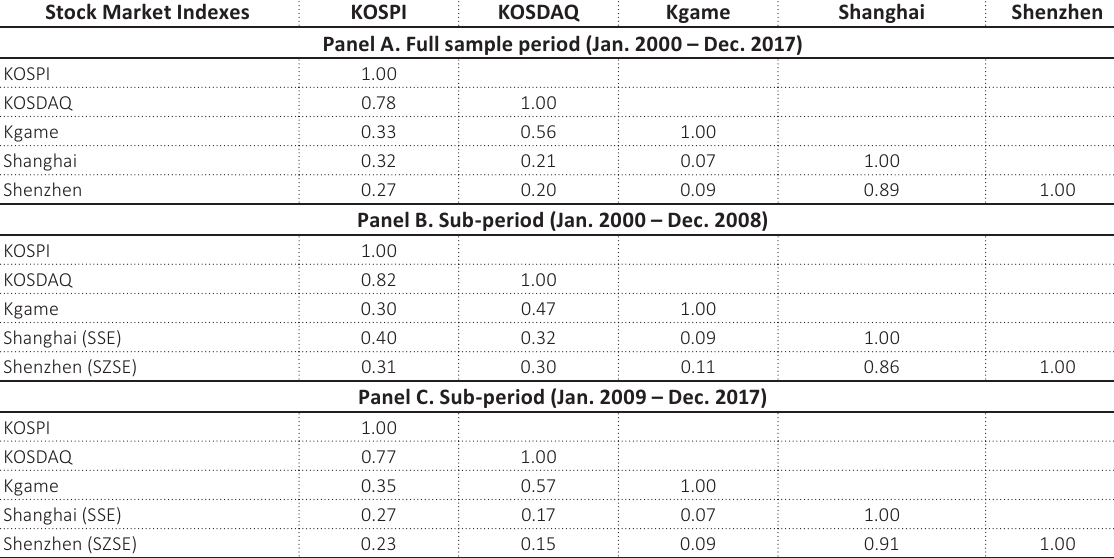
Table 5. Correlation coefficients Stock Market